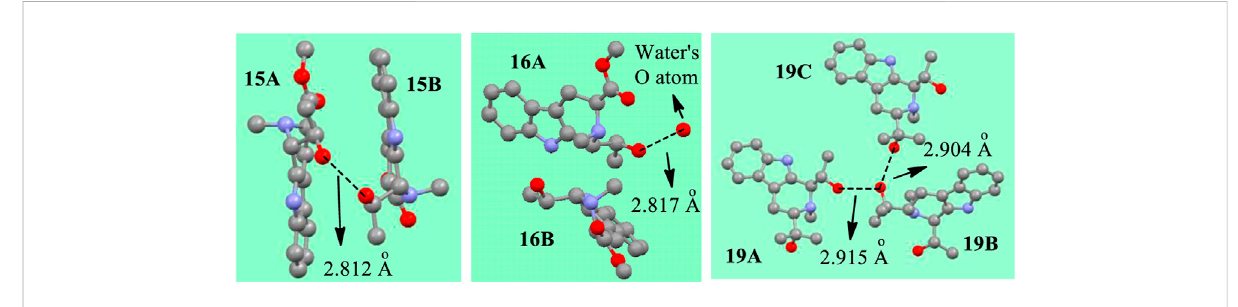
FIGURE 14 The distances between the O atoms in X-ray structures of 15 , 16 and 19 (The red balls represent O atoms, the grey represents C, the light blue means N . H atoms are omitted for